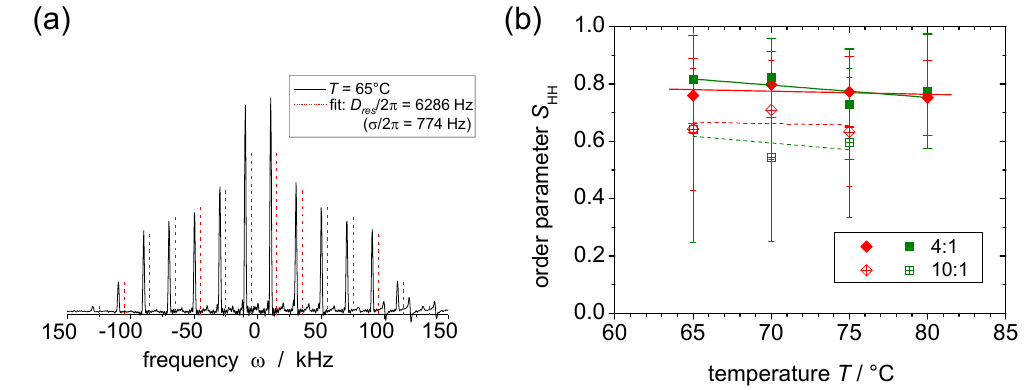
Figure 17. ( a ) DQ spinning sideband pattern for B12 in 1:4 mixture with DPPC at 65 ◦ C (10 kHz MAS, 4 τ R recoupling), including a fit to obtain the 1 H– 1 H dipolar coupling and its distribution width; ( b ) Corresponding order parameters S HH for 4:1 and 10:1 DPPC/B12 mixtures evaluated for two aromatic signals each as a function of temperature. The error bars indicate the dipolar distribution width σ from the fit; the actual experimental error is smaller and apparent from the deviations from the trend lines. Figure adapted with permission from ref. [23]. Copyright 2016 Americal Chemical